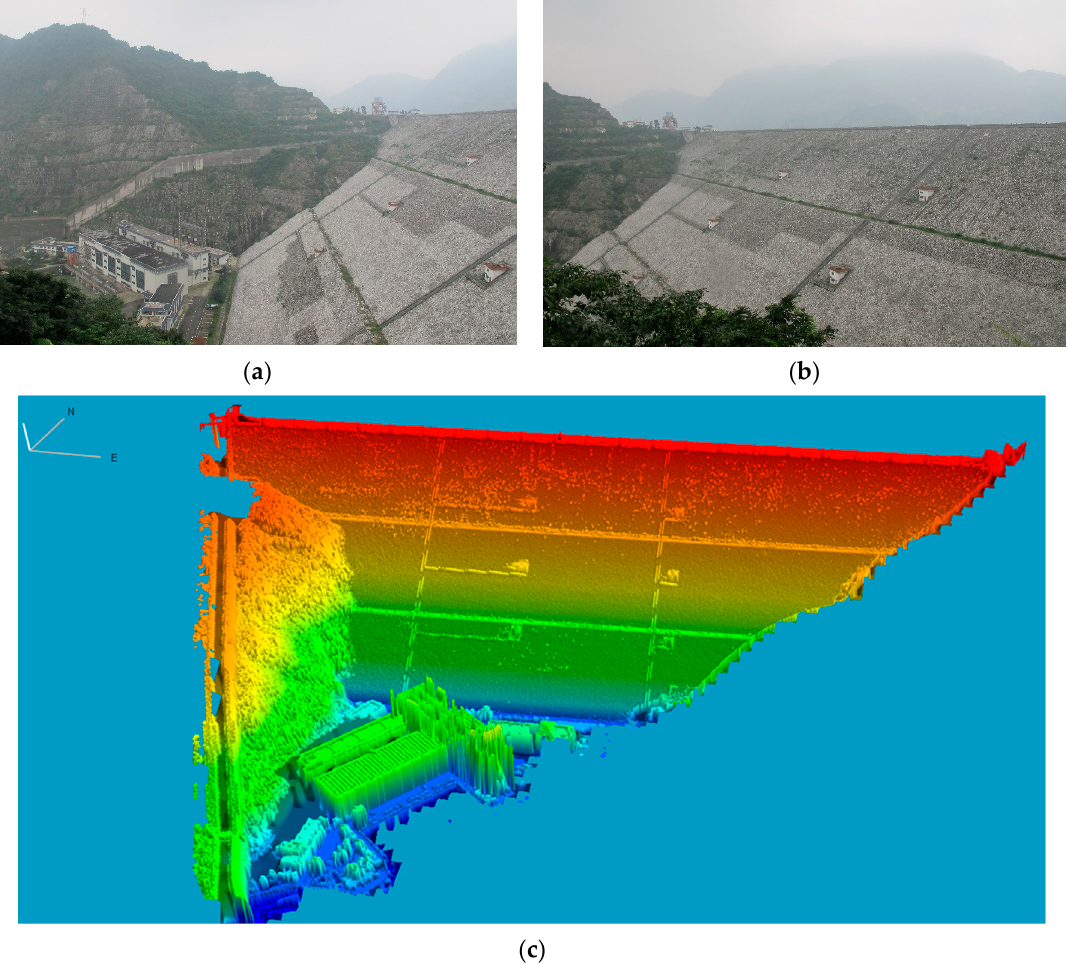
Figure 11. The fieldwork at Zipingpu Dam in Dujiangyan, Sichuan, China, LIDAR point cloud of Zipingpu Dam for validation obtained via a RIEGL VZ-1000. ( a ) Zipingpu Dam in Dujiangyan; ( b ) Zipingpu Dam in Dujiangyan; ( c ) Lidar point cloud of Zipingpu Dam, only the dam data were obtained in the fieldwork (the red triangle area shown in Figure 10).